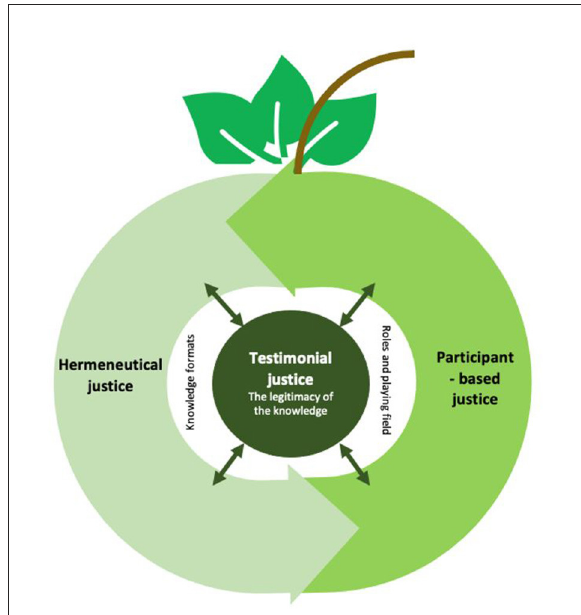
FIGURE1 Model of interrelationships between the different forms of knowledge